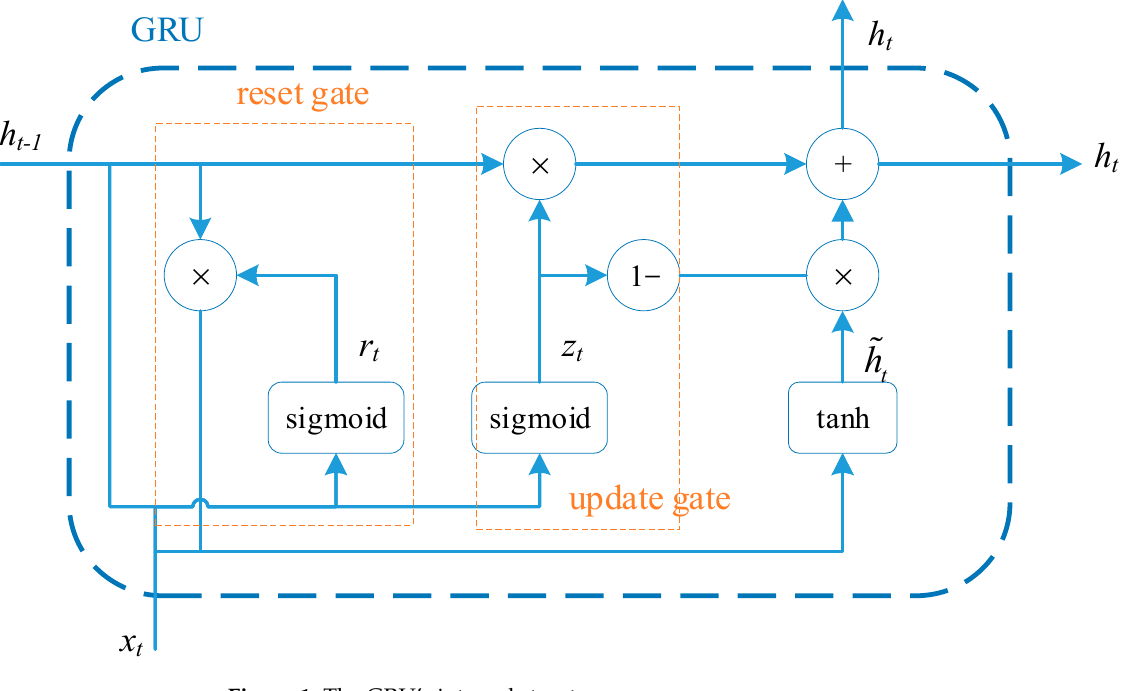
Figure 1. The GRU’s internal structure.